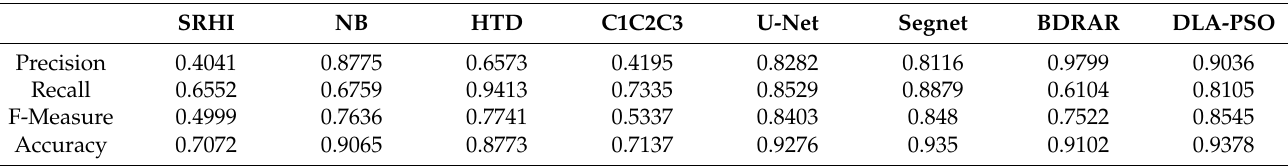
Table 4. Innsbruck shadow-test-evaluation